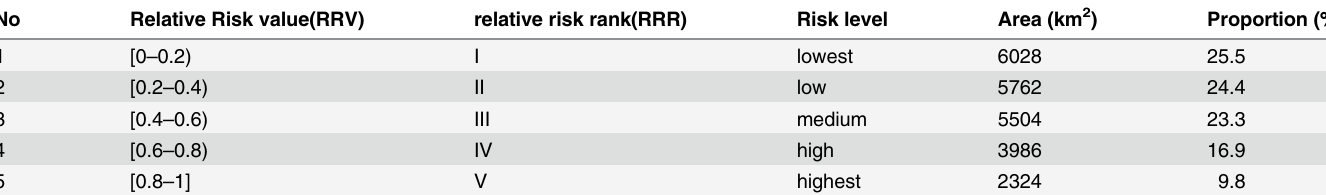
Table 5. Regional Groundwater Environment Risk assessment RRR in the study